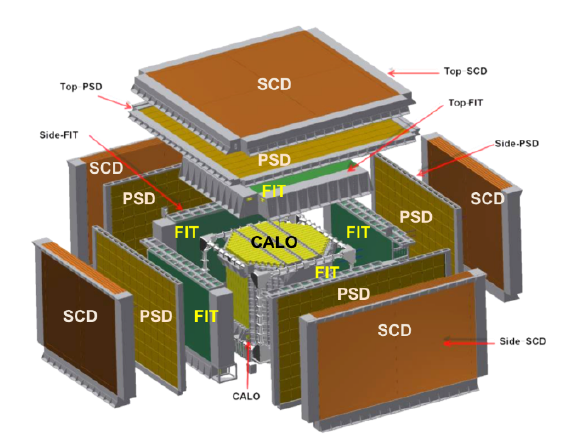
Figure 15. Preliminary schematic design of the HERD experi- ment. The calorimeter (CALO), the scintillating FIber Tracker (FIT), the Plastic Scintillator Detector (PSD) and the Silicon Charge Detector (SCD) are shown [33].